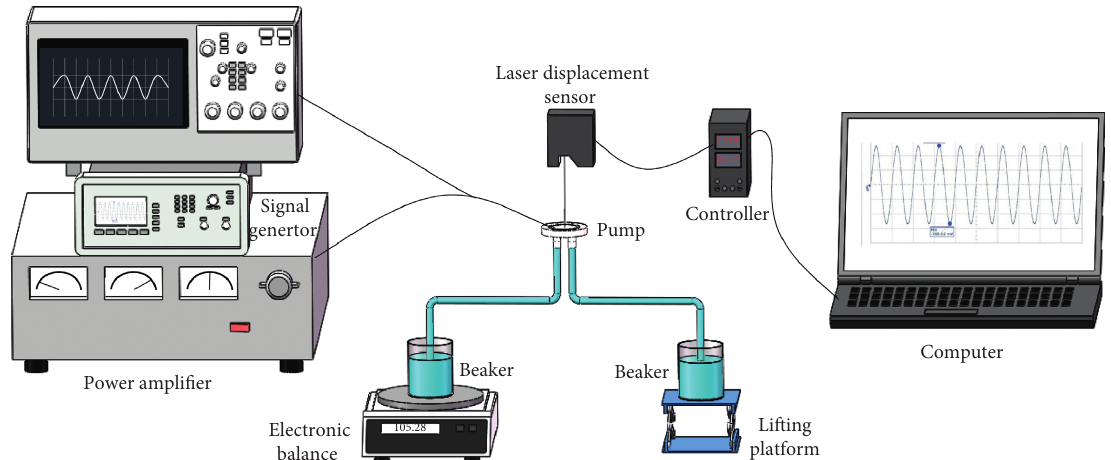
Figure 5: The experimental schematic diagram.